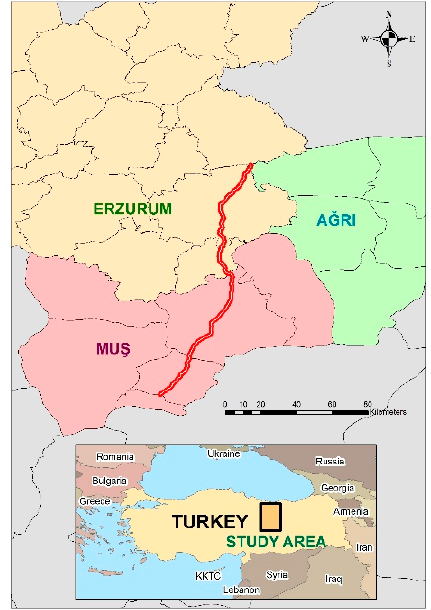
Figure 1. Study area; Mu ş natural gas pipeline project (MP) covering Erzurum, A ğ r ı and Mu ş provinces.